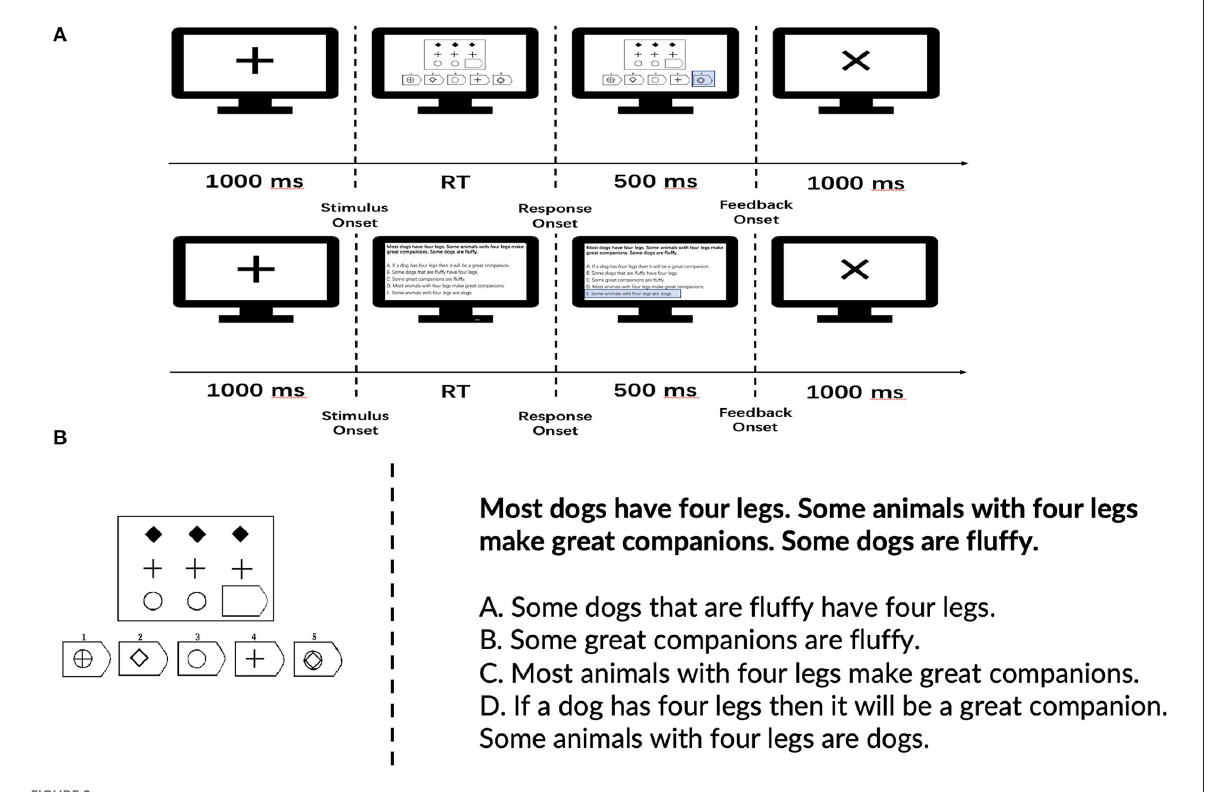
FIGURE2 (A) Experimental procedure of the two tasks. RT denotes reaction time, (B) examples according to the type of reasoning task—symbolic reasoning on the left-hand side and deductive reasoning on the right-hand